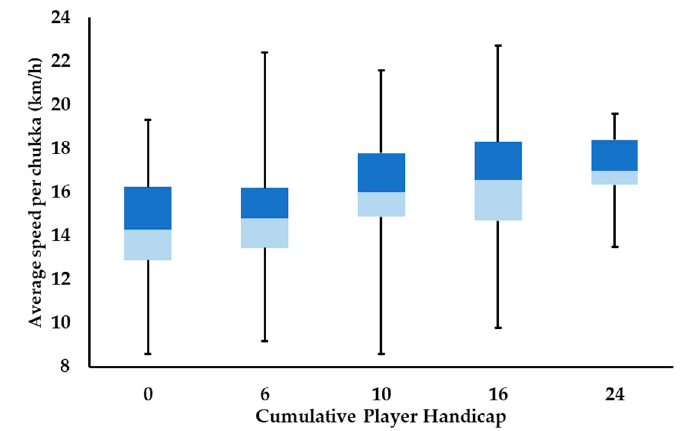
Figure 2. Box-plot of the median average speed (km/h) per chukka at each level of play. Lower and upper box boundaries 25th and 75th percentiles, respectively, line inside box median, lower and upper error lines minimum and maximum, respectively.